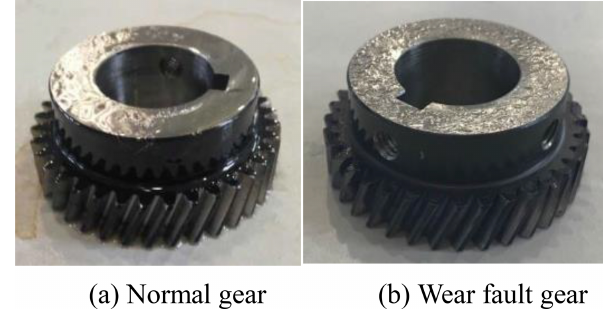
Figure 13. Gears used in experiment.